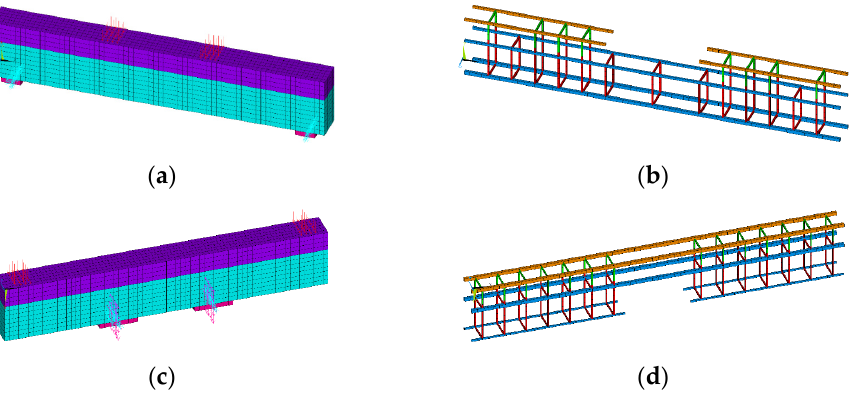
Figure 5. The finite element model of the concrete beam: ( a ) The component under a positive bending moment; ( b ) the reinforcement skeleton under a positive bending moment; ( c ) the component under a negative bending moment; and ( d ) the reinforcement skeleton under a negative bending moment.